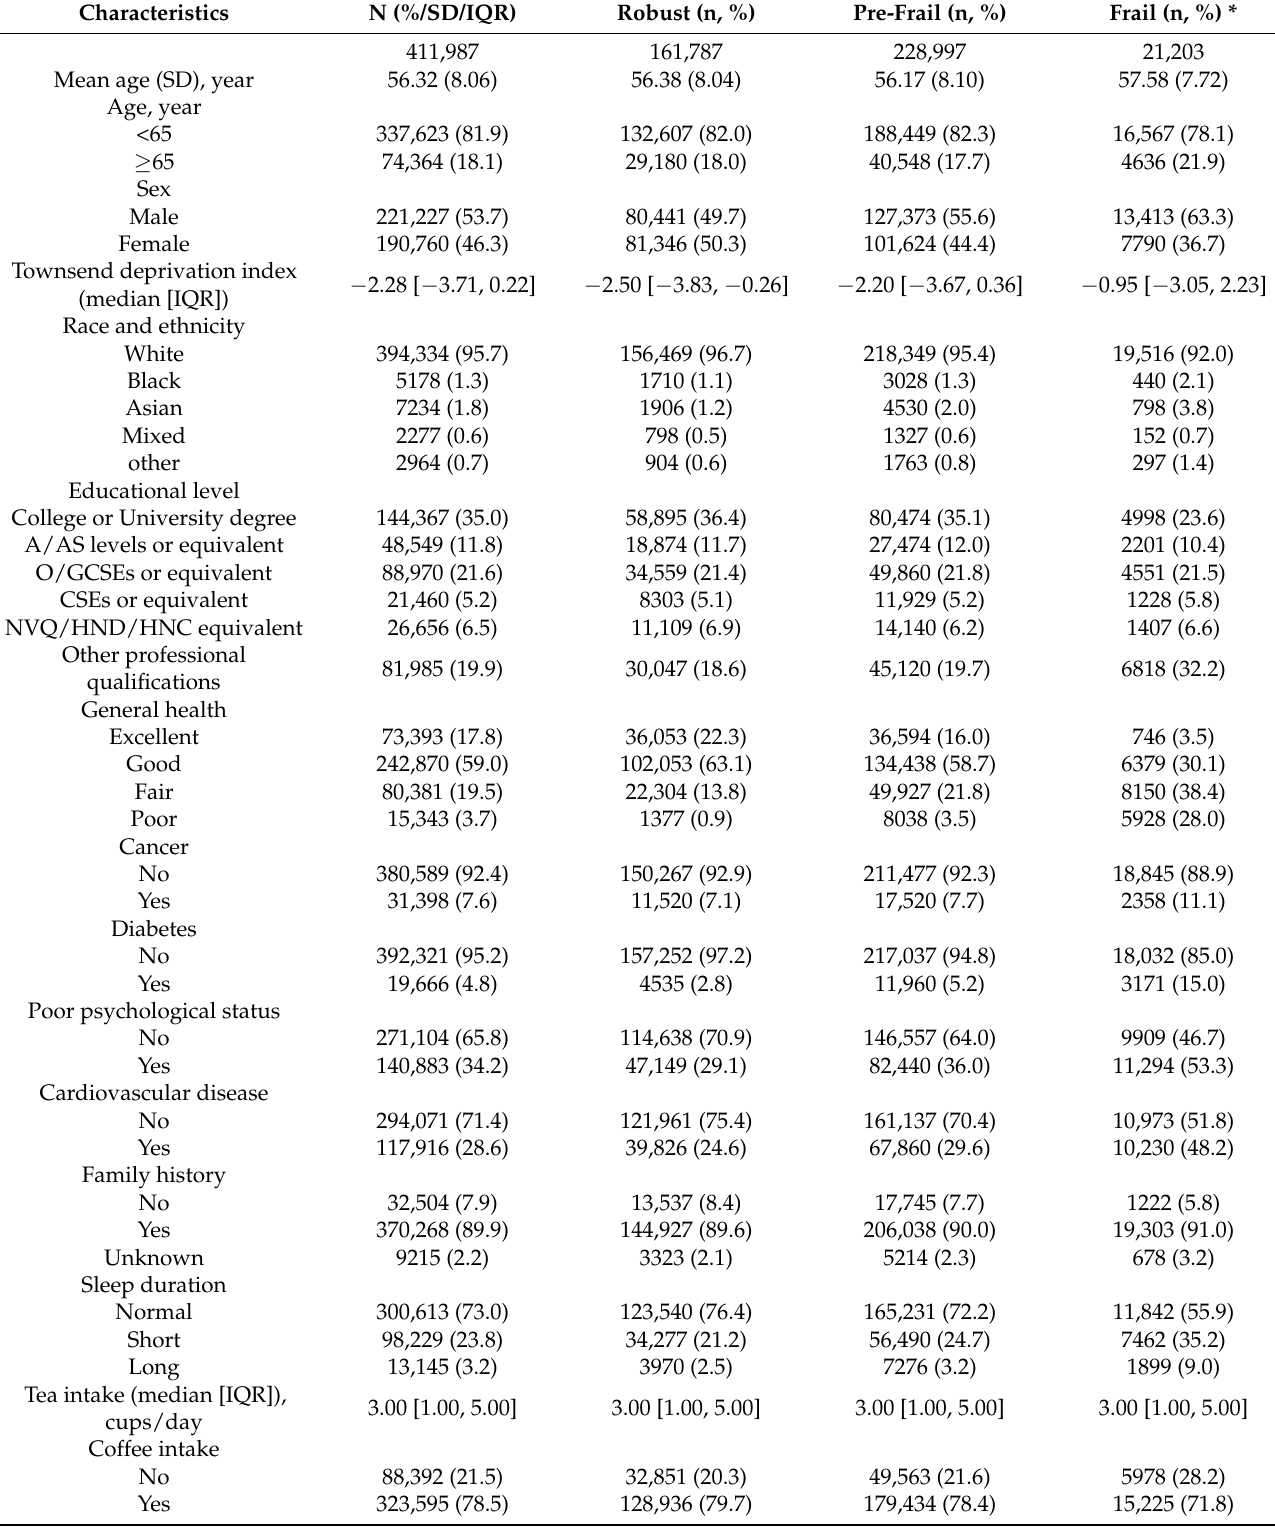
Table 1. Baseline characteristics of included